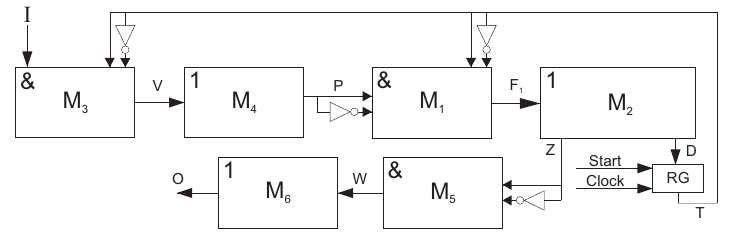
Figure 13. Structural diagram of MPY Mealy